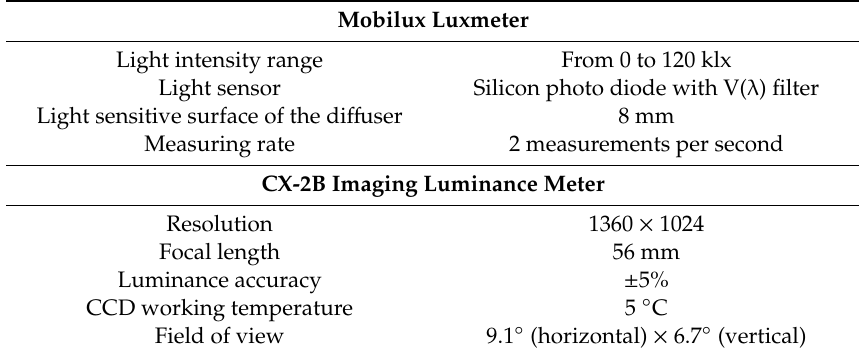
Figure 6. Positioning of the luminance meter for the road data collection. Table 2. Technical features of the Mobilux luxmeter and the CX-2B imaging luminance meter.